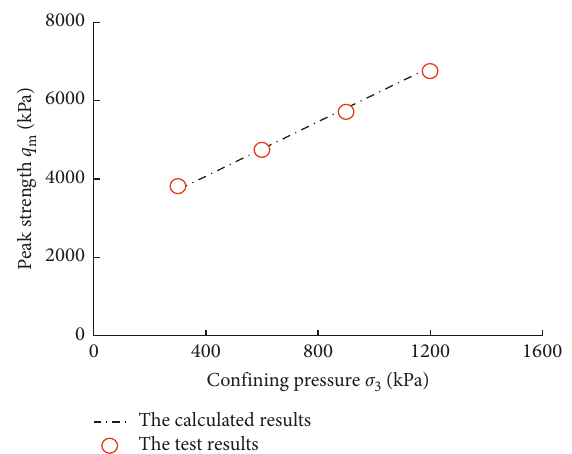
Figure 12: Comparison of the test results and calculated